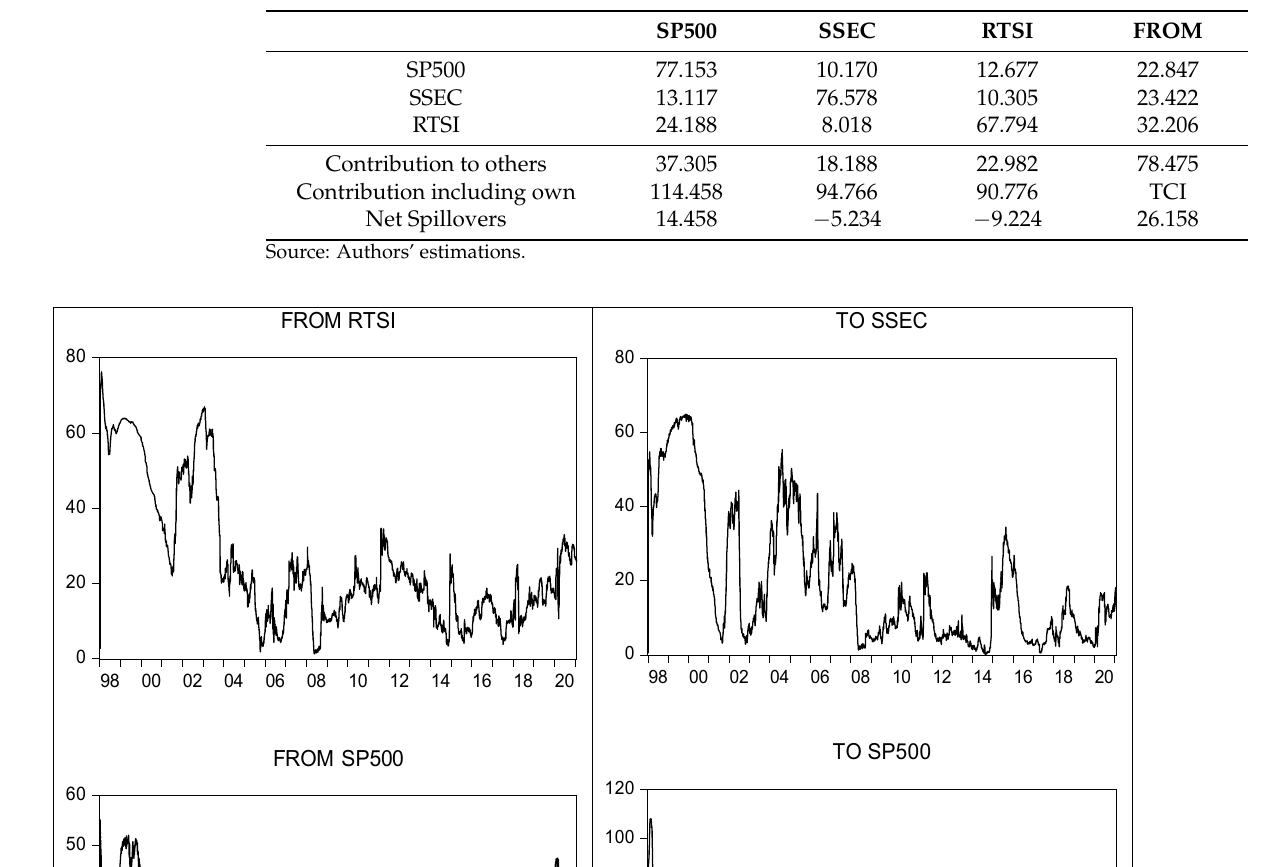
Table 3. Total connectedness among US, Russian and Chinese stock markets.